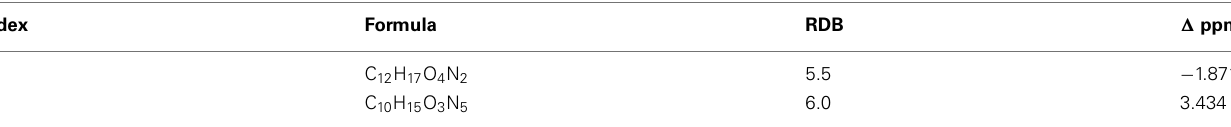
TableA4 | Chemical formulae calculated with m/ z 253.